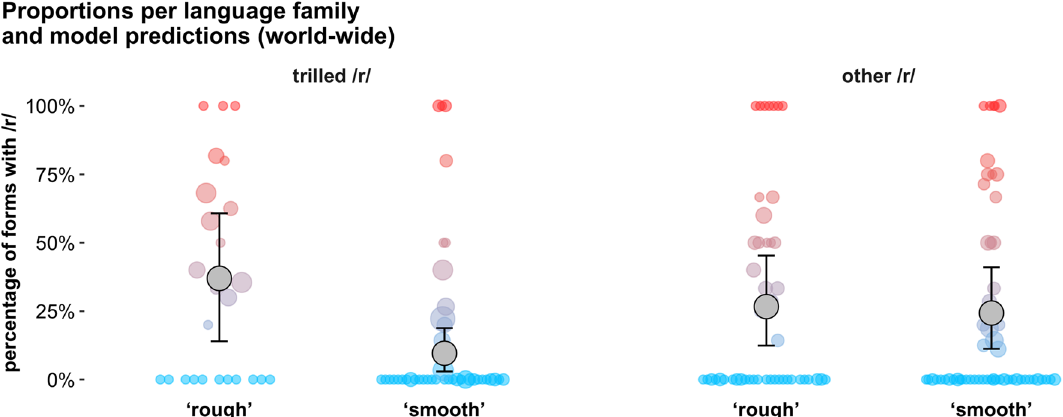
Figure 3. Left: Languages with only a trilled /r/ in their phoneme inventory (n = 179); Right: languages with other types of /r/ (n = 153). Results are aggregated by language family, with each colored dot representing a family (size of the circle = number of languages). Grey dots and whiskers show model predictions along with 95% Bayesian credible intervals. In languages with trilled /r/, words for ‘rough’ have a higher proportion of /r/ (posterior mean = 37%) than words for ‘smooth’ (10%); virtually no difference is observed for languages with other types of